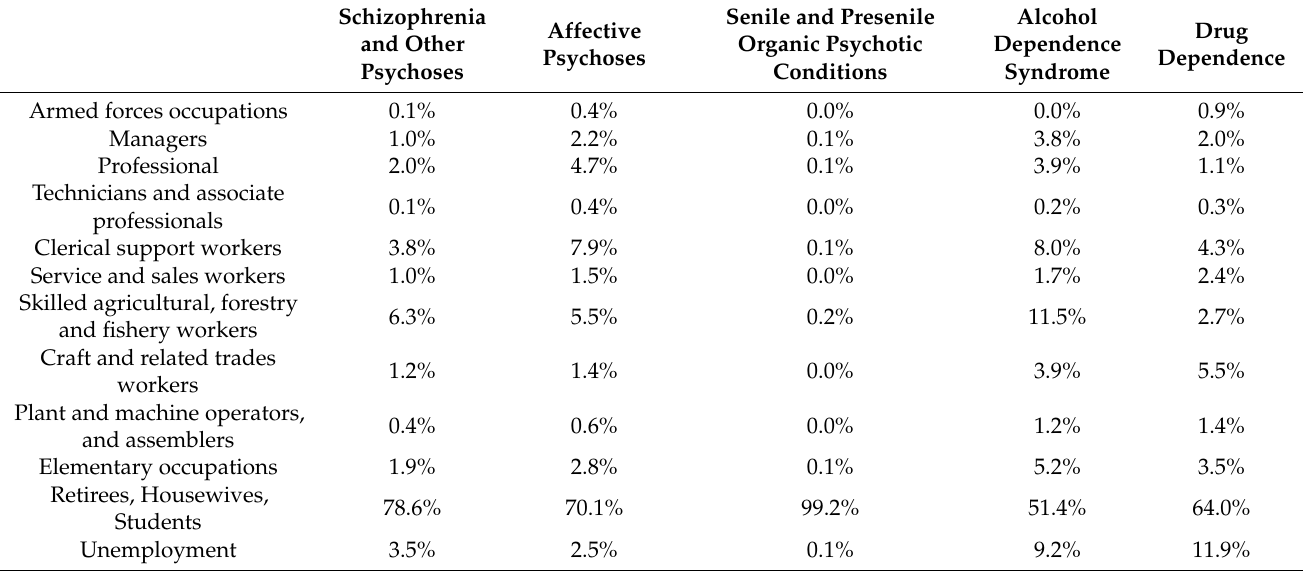
Table 6. Distribution of occupation among discharged patients with mental